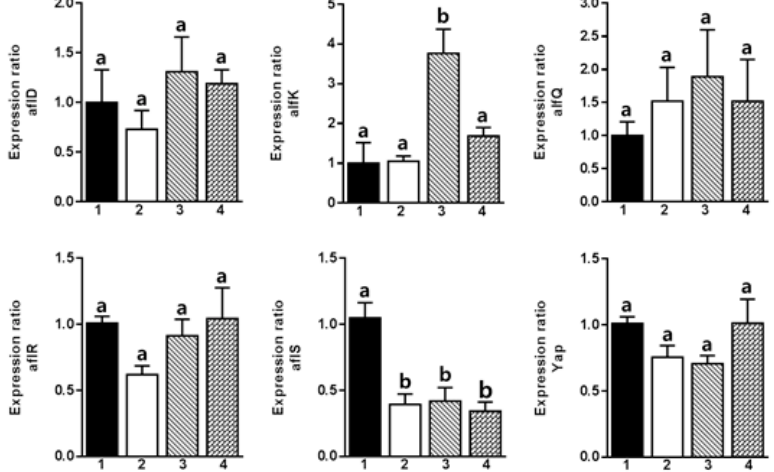
Figure 3. RT-PCR results of aflatoxin biosynthesis using six genes ( aflD , aflK , aflQ , aflR , aflS , and yap ) regulated by 2,3-dihydrobenzofuran ( 5 ). 1: control; 2: 1000 µ g/mL of 5 ; 3: 100 µ g/mL of 5 ; 4: 10 µ g/mL of 5 ). Different letters indicate statistically significant differences between experimental groups analyzed by a Student’s t -test ( p < 0.05).